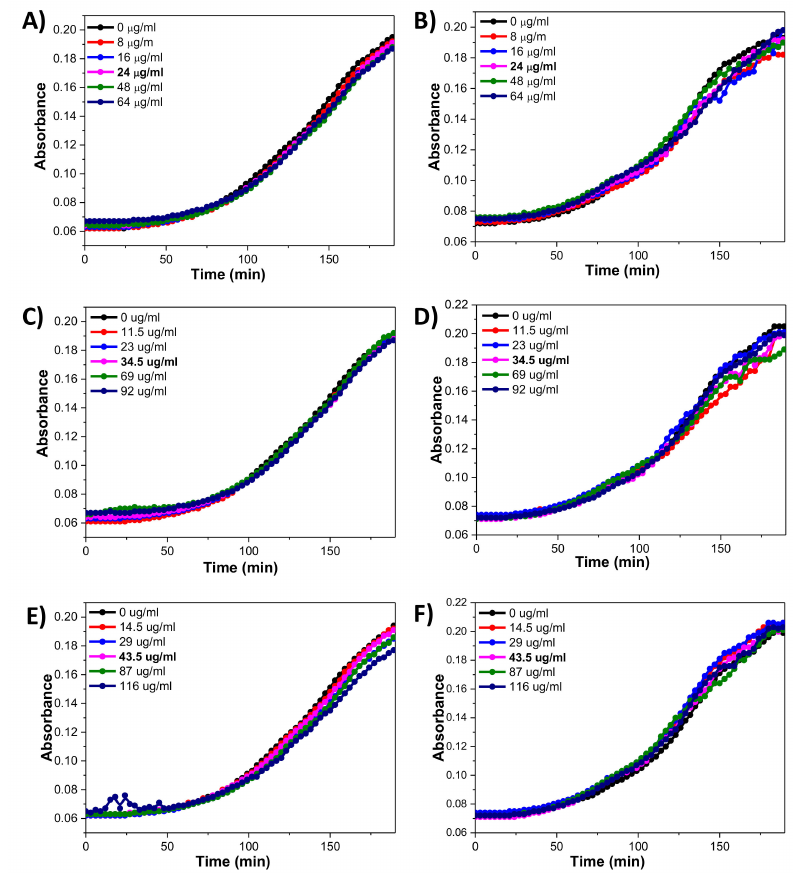
Figure 10. Growth curves of E. coli with OD 600 of 0.06 under di ff erent concentrations of